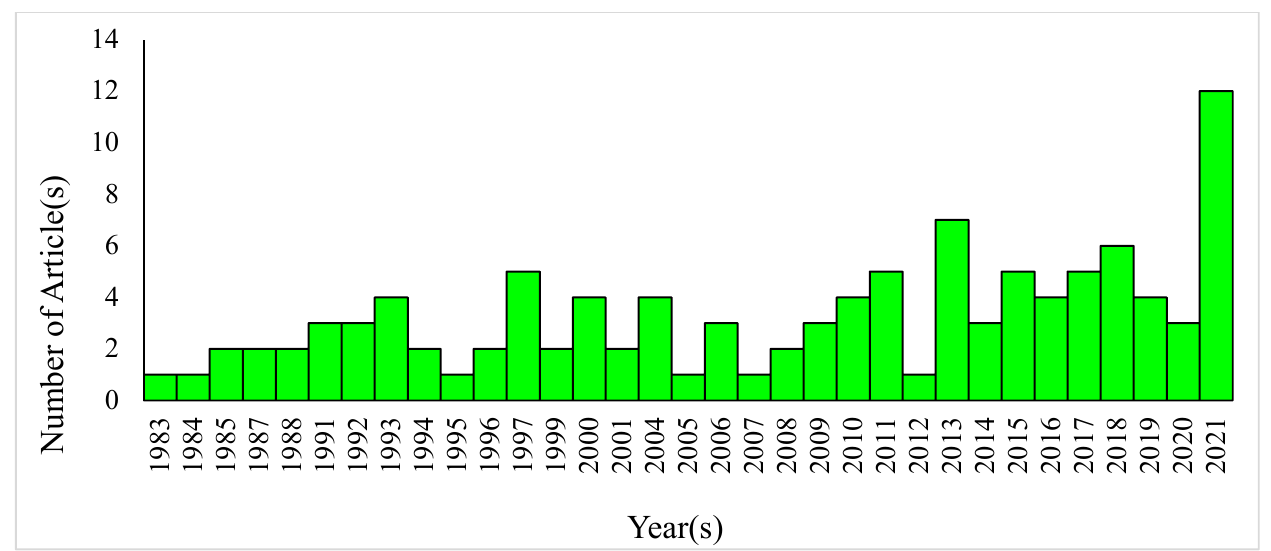
Figure 3. Number of articles published between 1983 and 2021 that used Tunicamycin in breast cancer studies. The information was collected from PubMed (https://pubmed.ncbi.nlm.nih.gov (accessed on 26 September 2021)) Search query: Tunicamycin AND breast cancer.